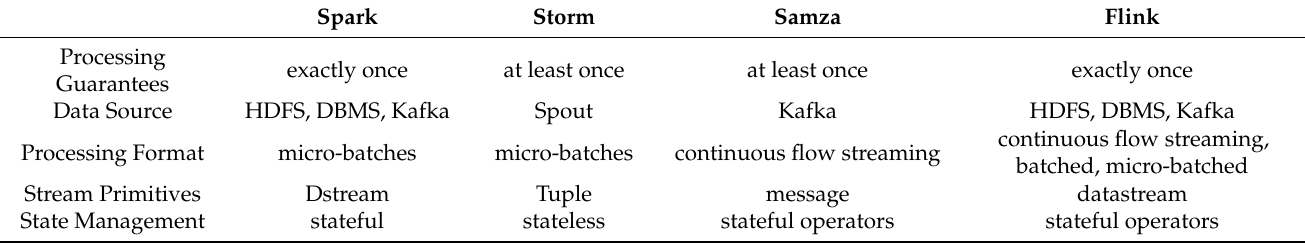
Table 9. Comparison of big data frameworks with respect to features related to stream processing.